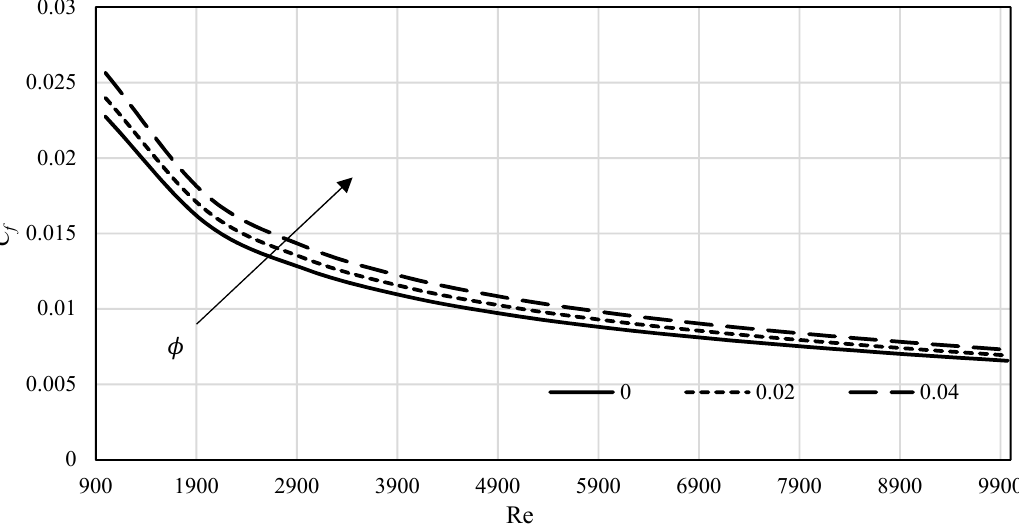
Figure 11. 𝐶 (cid:3033) versus the Reynolds number at different volume fractions 𝜙 (Al 2 O 3 ).